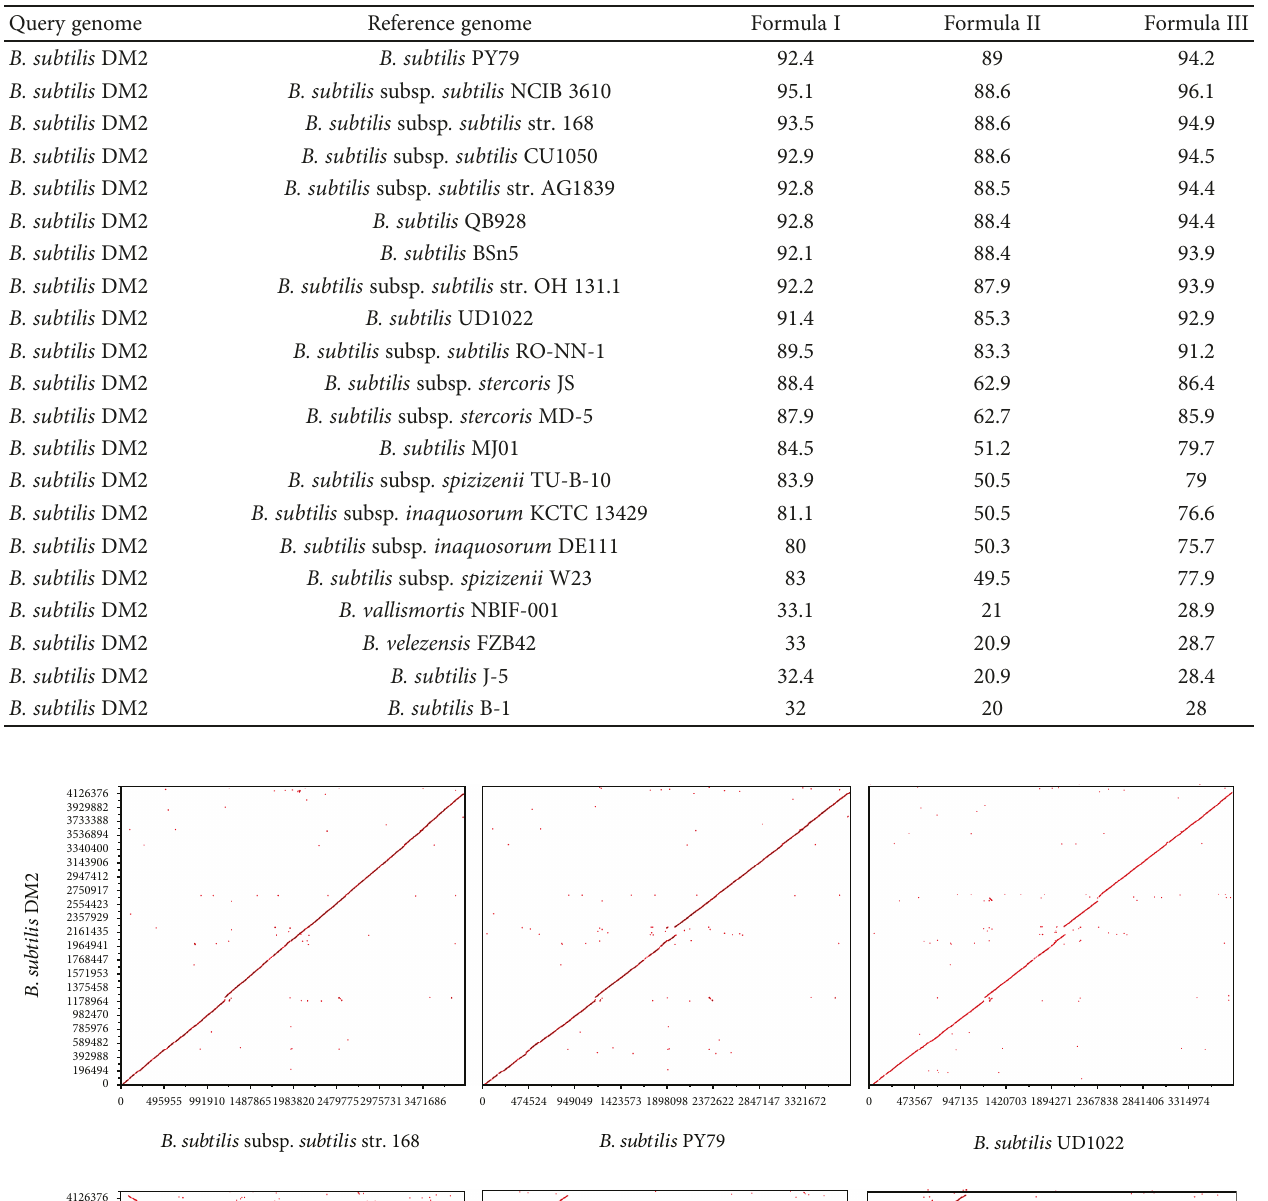
Table 3: DNA-DNA hybridization values as calculated by GGDC server.